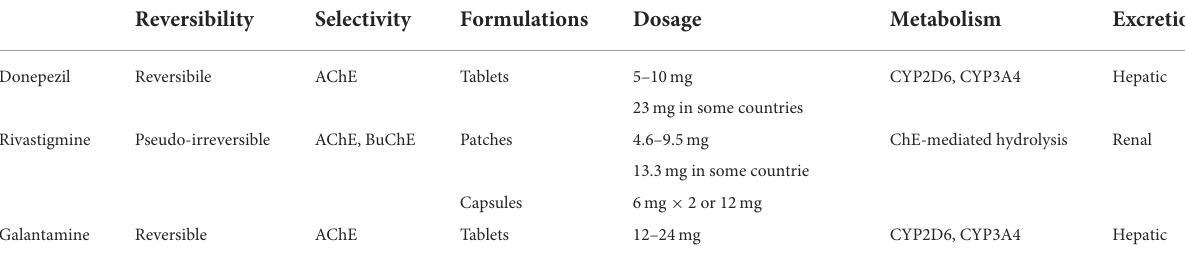
TABLE 1 Pharmacological properties of available acetylcholinerase